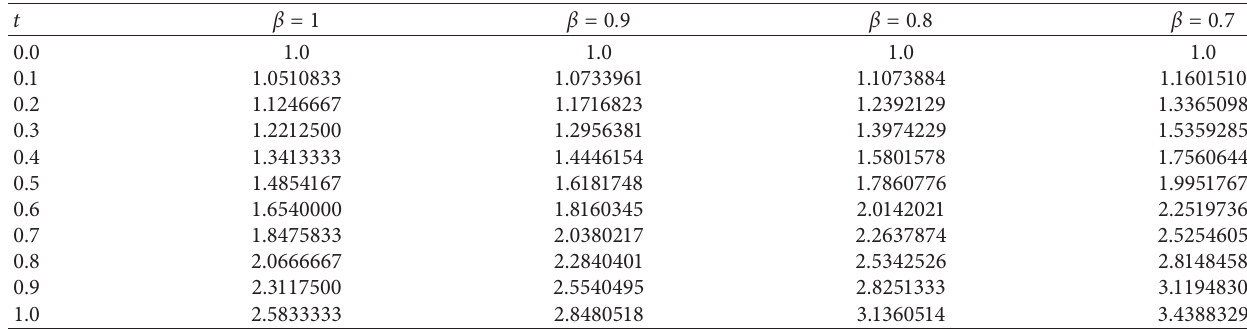
( t ) for Example 1 at different values of fractional order β , k � 6, and t ∈ [ 0 , 1 ] . 1 , 6